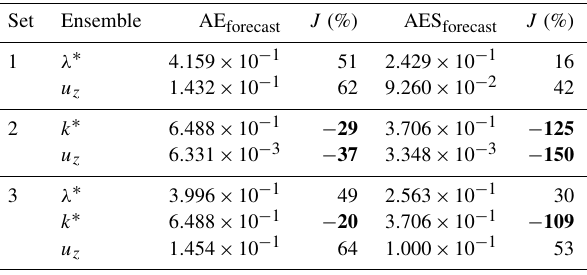
Table 4. Testing ES approach in a predictive sense for set #1. Vari- ations J of AE and AES from the update ensembles assimilating 5, 7 and 10 years of measurements. The AE and AES indices for the forecast ensembles are the same of Table 3. Negative values are highlighted in